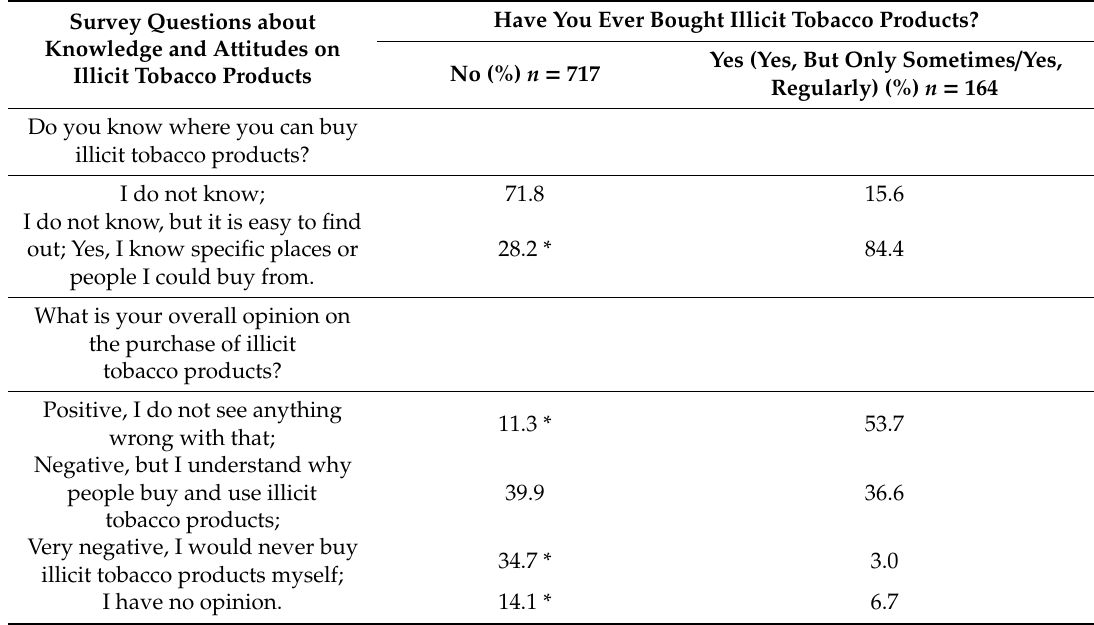
Table 5. Distribution of respondents by knowing where to buy illicit tobacco products and opinion on the purchase according to purchase history of illicit tobacco products.